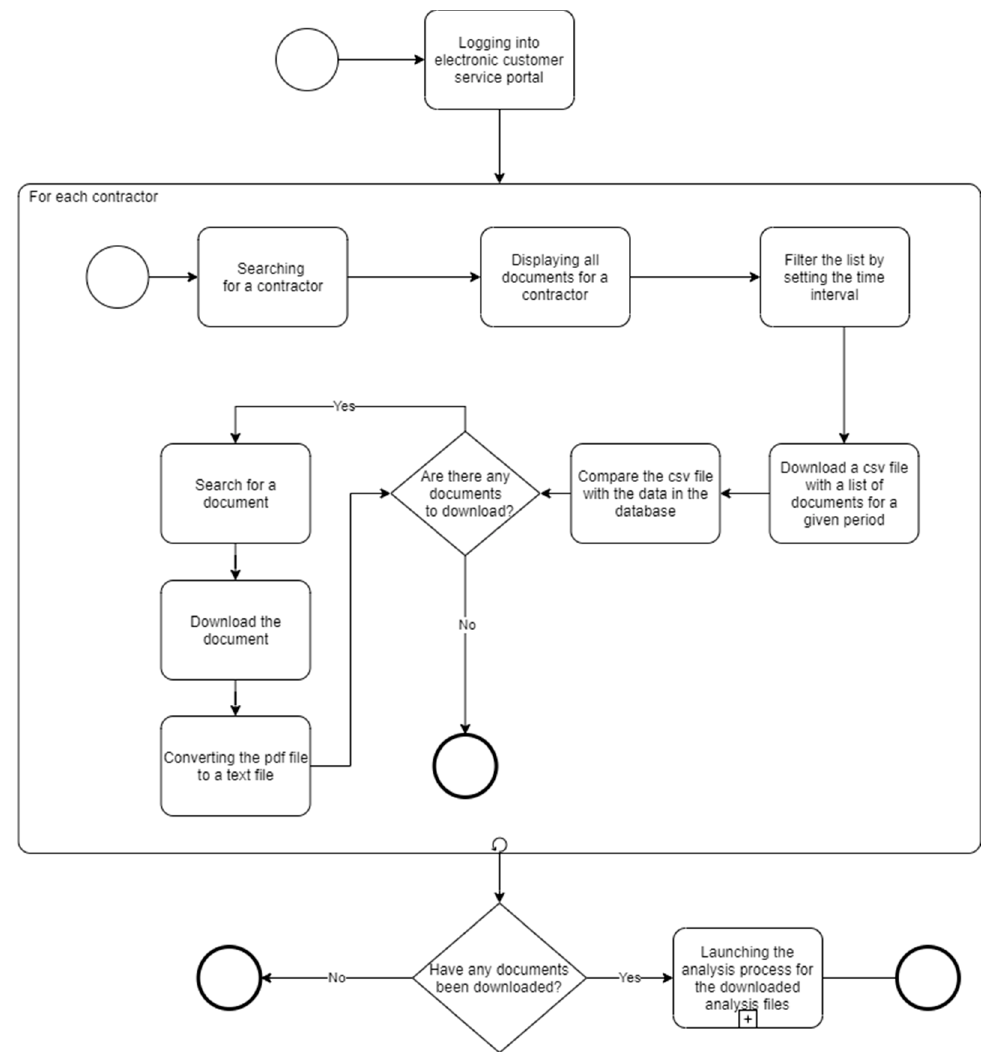
Figure 3. The operational model of the software robot developed using the RPA tool addressing the processing of electricity billing documents for the City of Bydgoszcz. Source: proprietary com- pilation based on [ Error! Reference source not found. ].